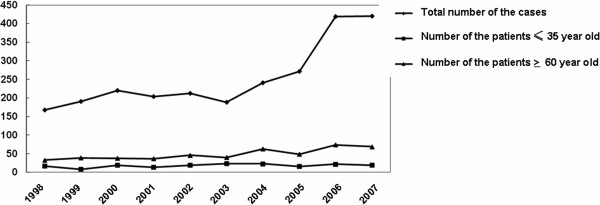
Analysis of numbers of the female breast cancer case, including the young and older breast cancer cases, diagnosed in the hospital in the past 10 years.